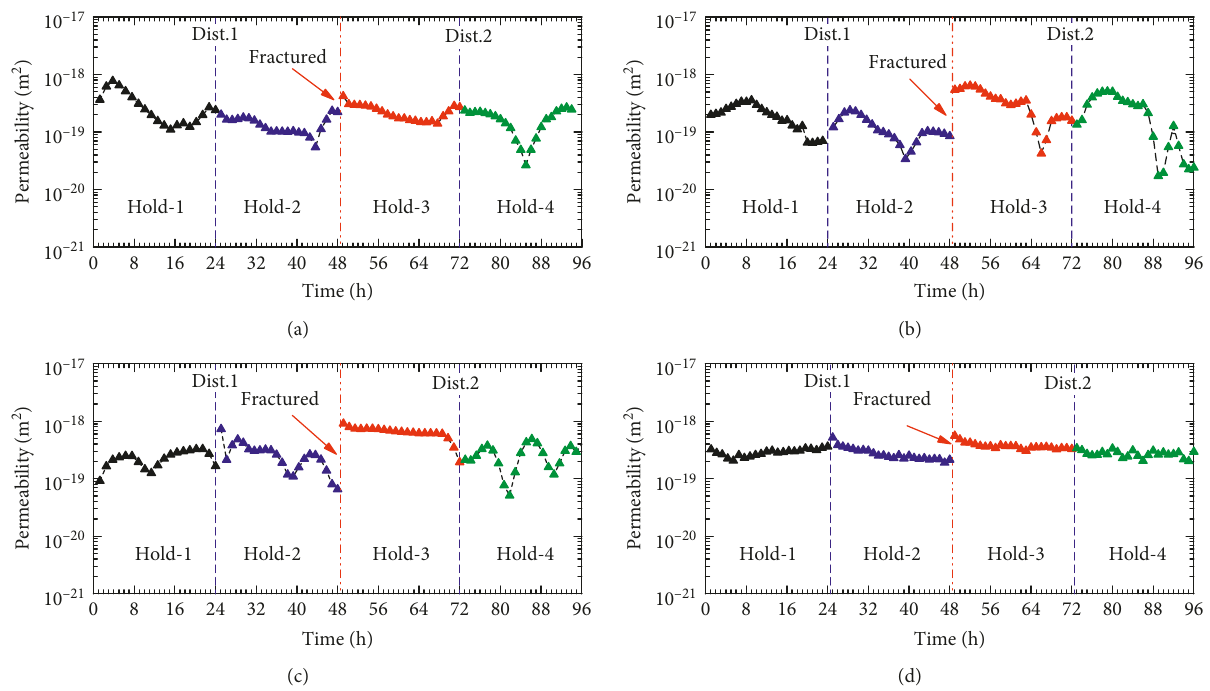
Figure 12: Variation in permeability in each hydrostatic stress state (Hold-1, Hold-2, Hold-3, and Hold-4) at the time of transient pore stress disturbances for the whole experiment: (a) P p -KCS1, (b) P p -KCS4, (c) P p -KCS6, and (d) P p -KCS7. Dist. 1 and Dist. 2 are the disturbances in prefailure and postfailure, respectively.